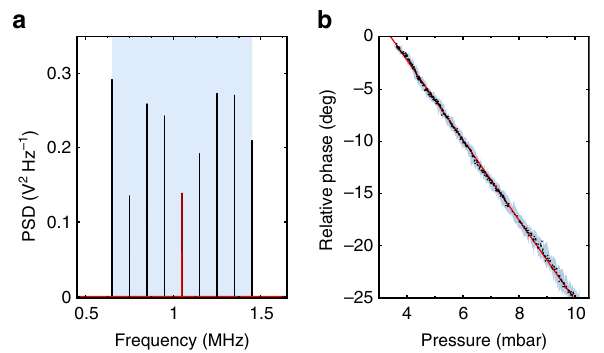
Fig. 4 Sensing applications. a At 4 mbar, the locking frequency f d can be continuously tuned by over 800 kHz, which corresponds to almost 10 12 linewidths. The peaks in the PSD differ in amplitude since for short recording times they are not fully resolved. b In this parameter region the phase lag (black dots) between the rotor and the drive depends linearly on pressure ( fi tted red line) and thus can be used for precise pressure sensing. The pressure values are given by the reading of a commercial pressure Gauge (Pfeiffer Vacuum PCR 280), and the shaded region is the error margin as de fi ned by the manufacturer-given resolution and repeatability of the